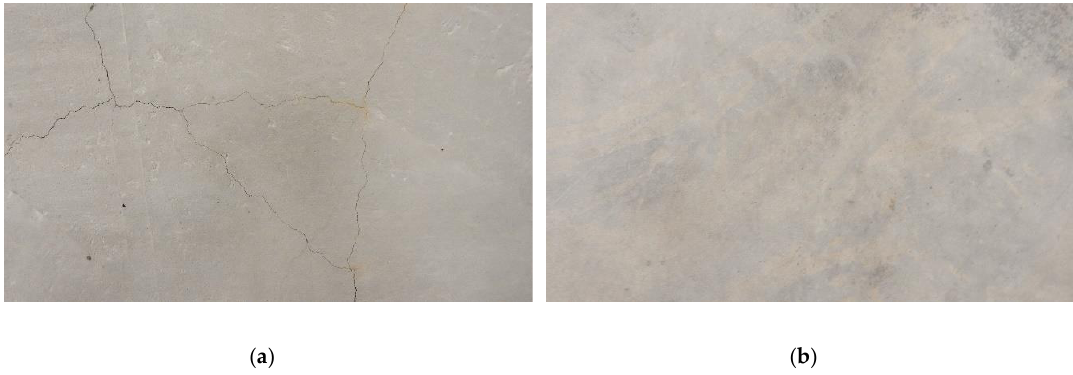
Figure 3. Representative images of ( a ) cracked concrete and ( b ) sound concrete.